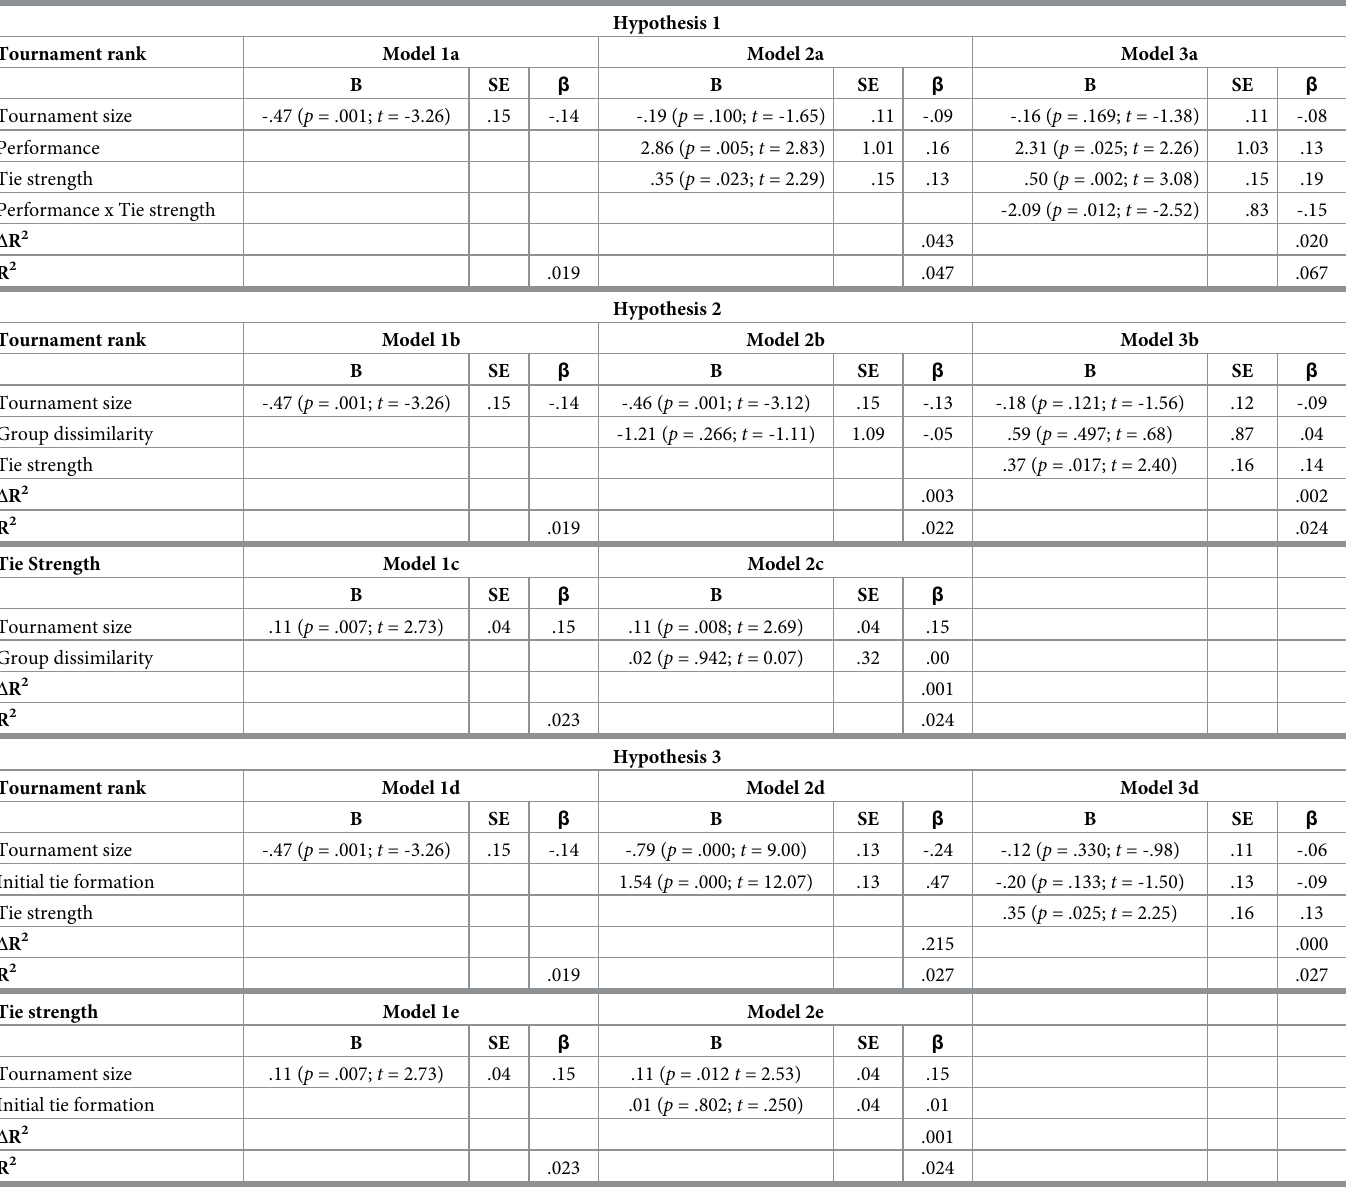
Table 2. Regression